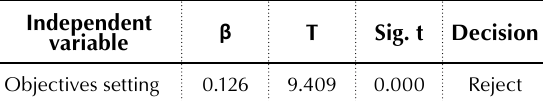
Table 3. Results of a simple linear regression